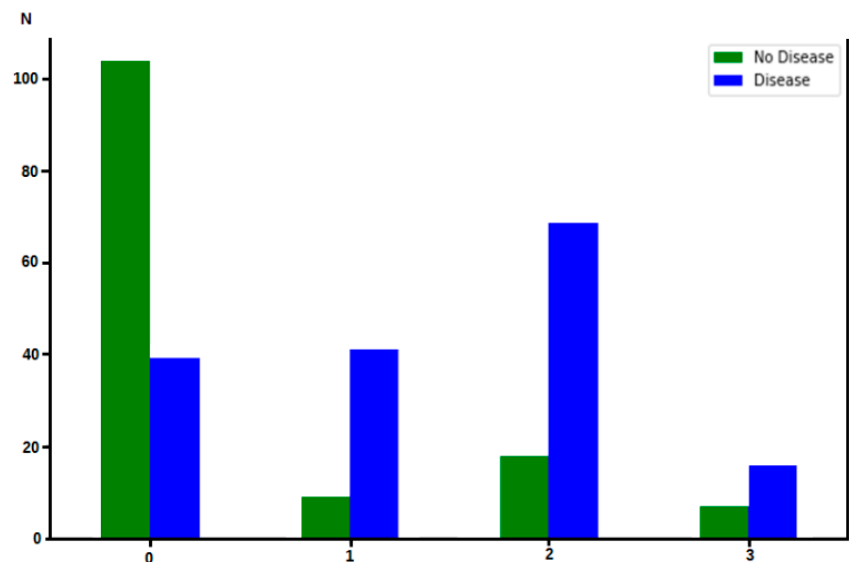
Figure 6. Chest pain and risk of MI.